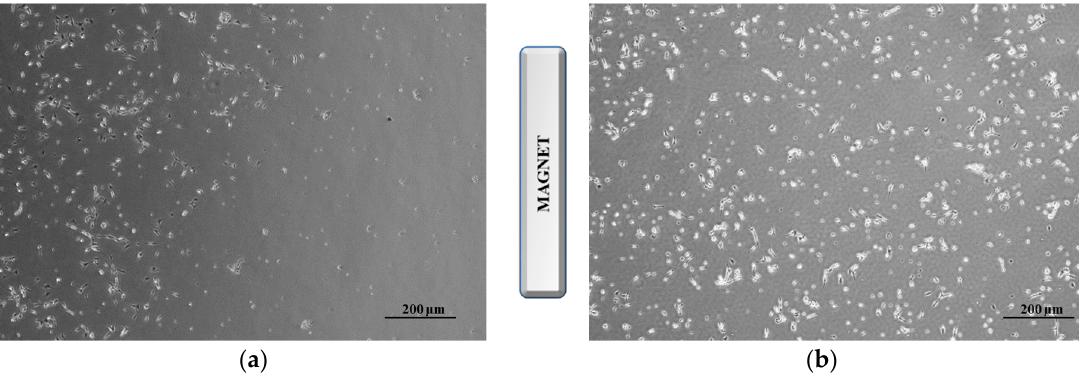
Figure 9. Optical microscope image SH-SY5Y incubated with DOX-C@HSA-MNPs@rGO ( a ) and DOX-C@HSA-rGO ( b ) under the effect of a permanent magnet.